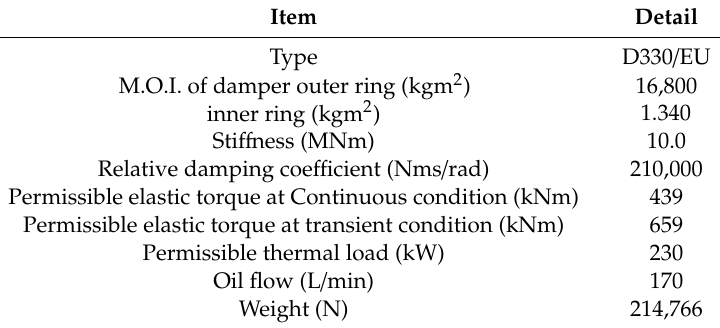
Table 2. Specifications for torsional vibration